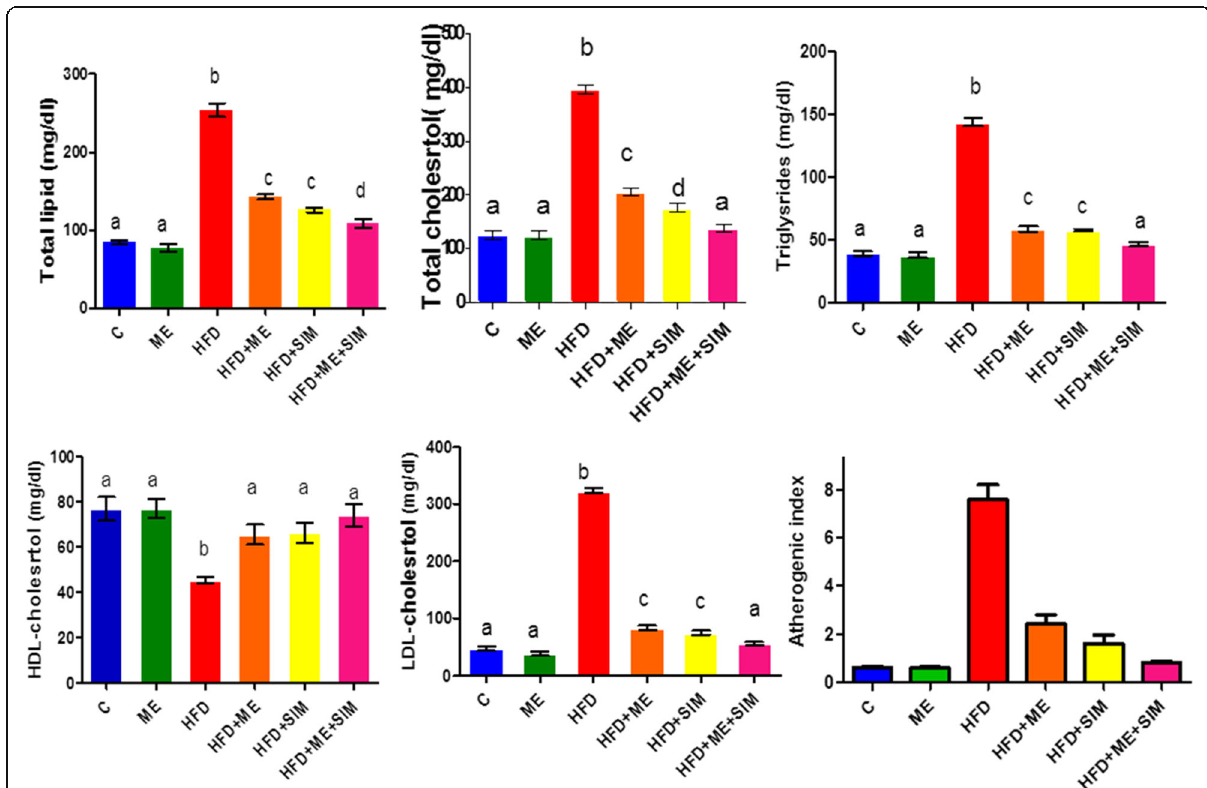
Fig. 1 The effects of Moringa leaf extract (ME), simvastatin (SIM) and their combination (ME+SIM) on lipid fractions (Total lipids, triglycerides (TG), total cholesterol (TC), low-density lipoprotein and (LDL) high-density lipoprotein (HDL))and atherogenic index in rats fed a high-fat diet (HFD) for 6 weeks. ME prevented the increase in serum levels of lipid fractions and the atherogenic index. Different letters indicate significant differences between groups ( p < 0.05). Values are means ±SD (n =